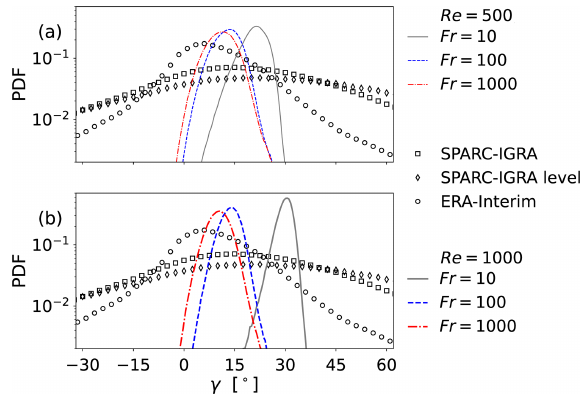
Figure 10. Probability density functions (PDFs) of the wind turning angle γ . In ODT, data was extracted at height z = D , which would be the thickness of the laminar Ekman layer. D is close to the loca- tion where the ensemble-averaged ageostophic velocity reaches its maximum. Reference data based on IGRA and SPARC soundings in North America and from an ERA-Interim reanalysis is shown for comparison. These reference data are taken from Lindvall and Svensson (2019), who performed the analysis by extracting hori- zontal velocity components at or at the level above the planetary boundary layer